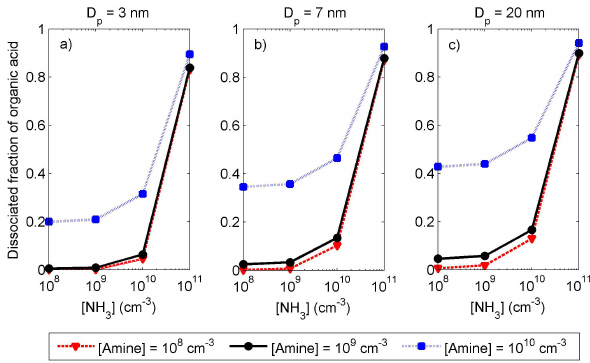
Fig. 3. Dissociated fraction of particle phase organic acid at par- ticle sizes (a) 3nm, (b) 7nm and (c) 20nm as a function of am- monia concentration for three amine concentrations. Concentra- tion and saturation vapour pressure of organic acid were set to 3 × 10 8 cm − 3 and 10 − 6 Pa, respectively. Other properties of or- ganic acid were as for organic acid 1 (Table 1). Sulfuric acid con- centration (10 6 cm − 3 ) , RH (40%) and temperature (283.15K) were set to base case values in all simulations (Table